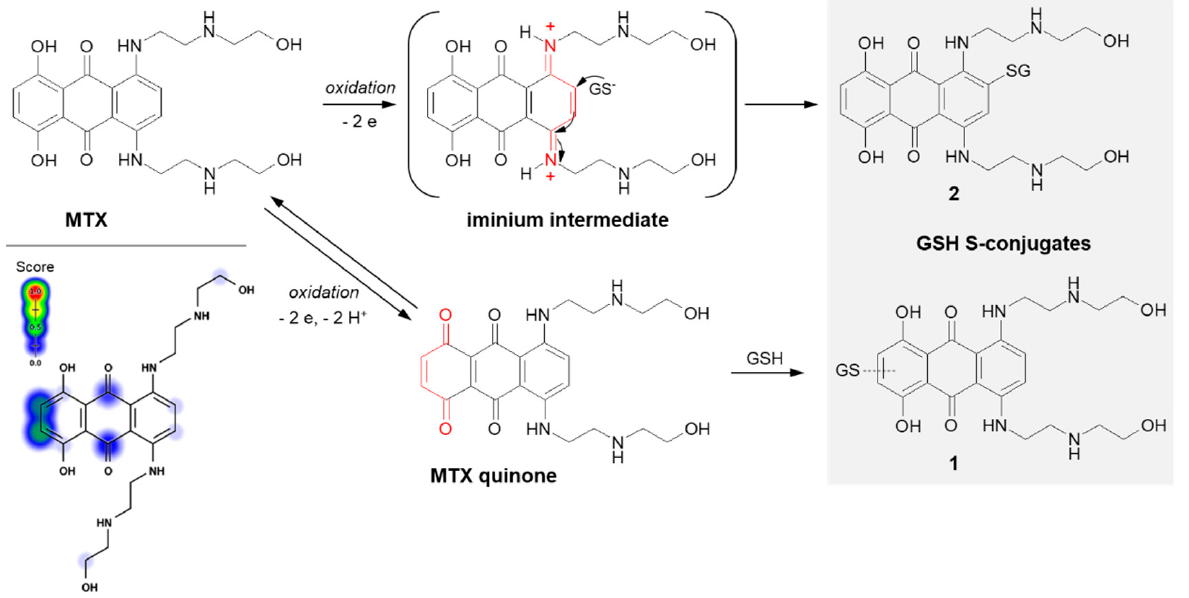
Figure 13. Scheme of mitoxantrone (MTX) activation and drug reaction with GSH [16,117]. The Michael acceptor moieties are marked in red. Predicted bioactive sites of GSH conjugation for anticancer drug were obtained by XenoSite Reactivity Predictor available at https://swami.wustl.edu/xenosite/p/reactivity (accessed on 18 May 2022).